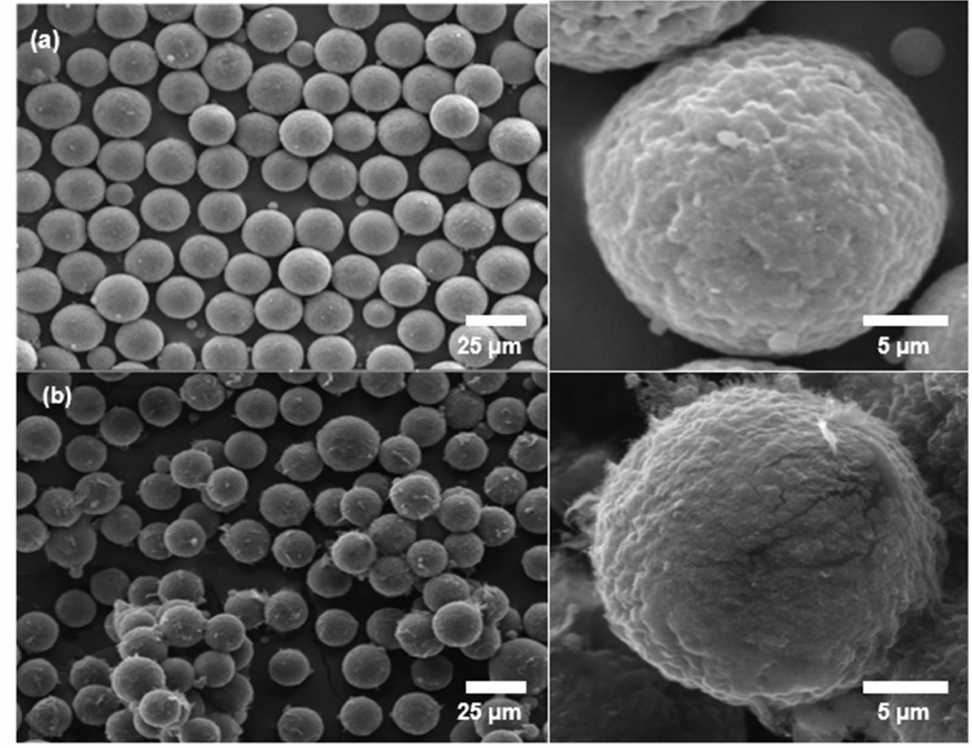
Figure 2. SEM micrographs of ( a ) uncoated PMMA beads and ( b ) MWCNT-coated PMMA beads.